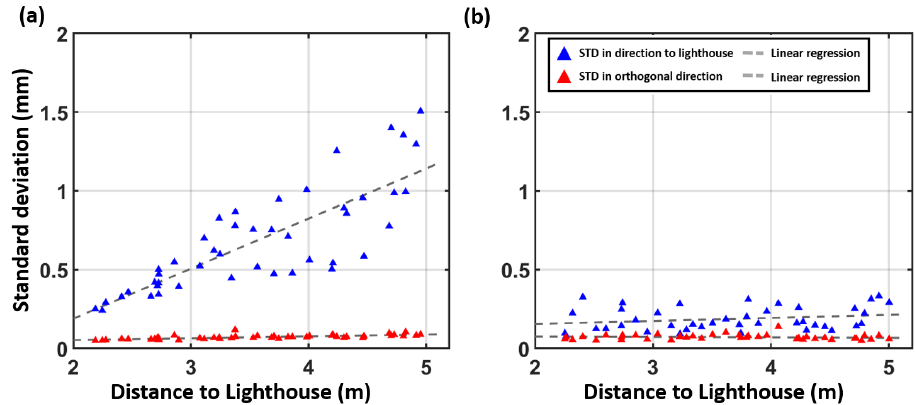
Figure 6. Distance dependency of the noise patterns of the tracker positions ( a ) with one lighthouse and ( b ) with two